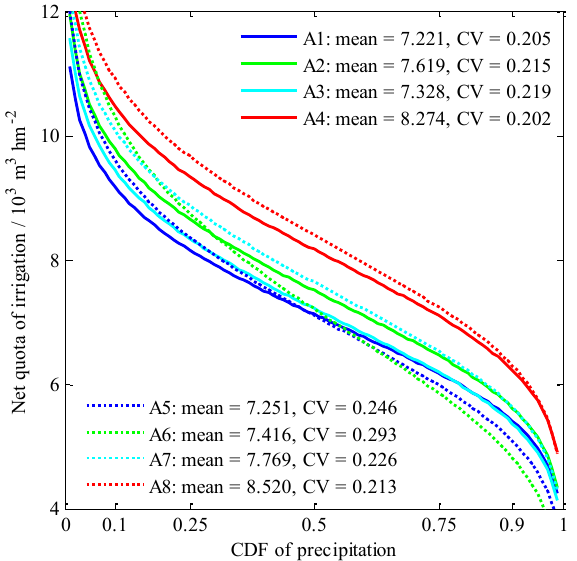
Figure 2. Net quota of irrigation for paddy fields in individual sub- regions.